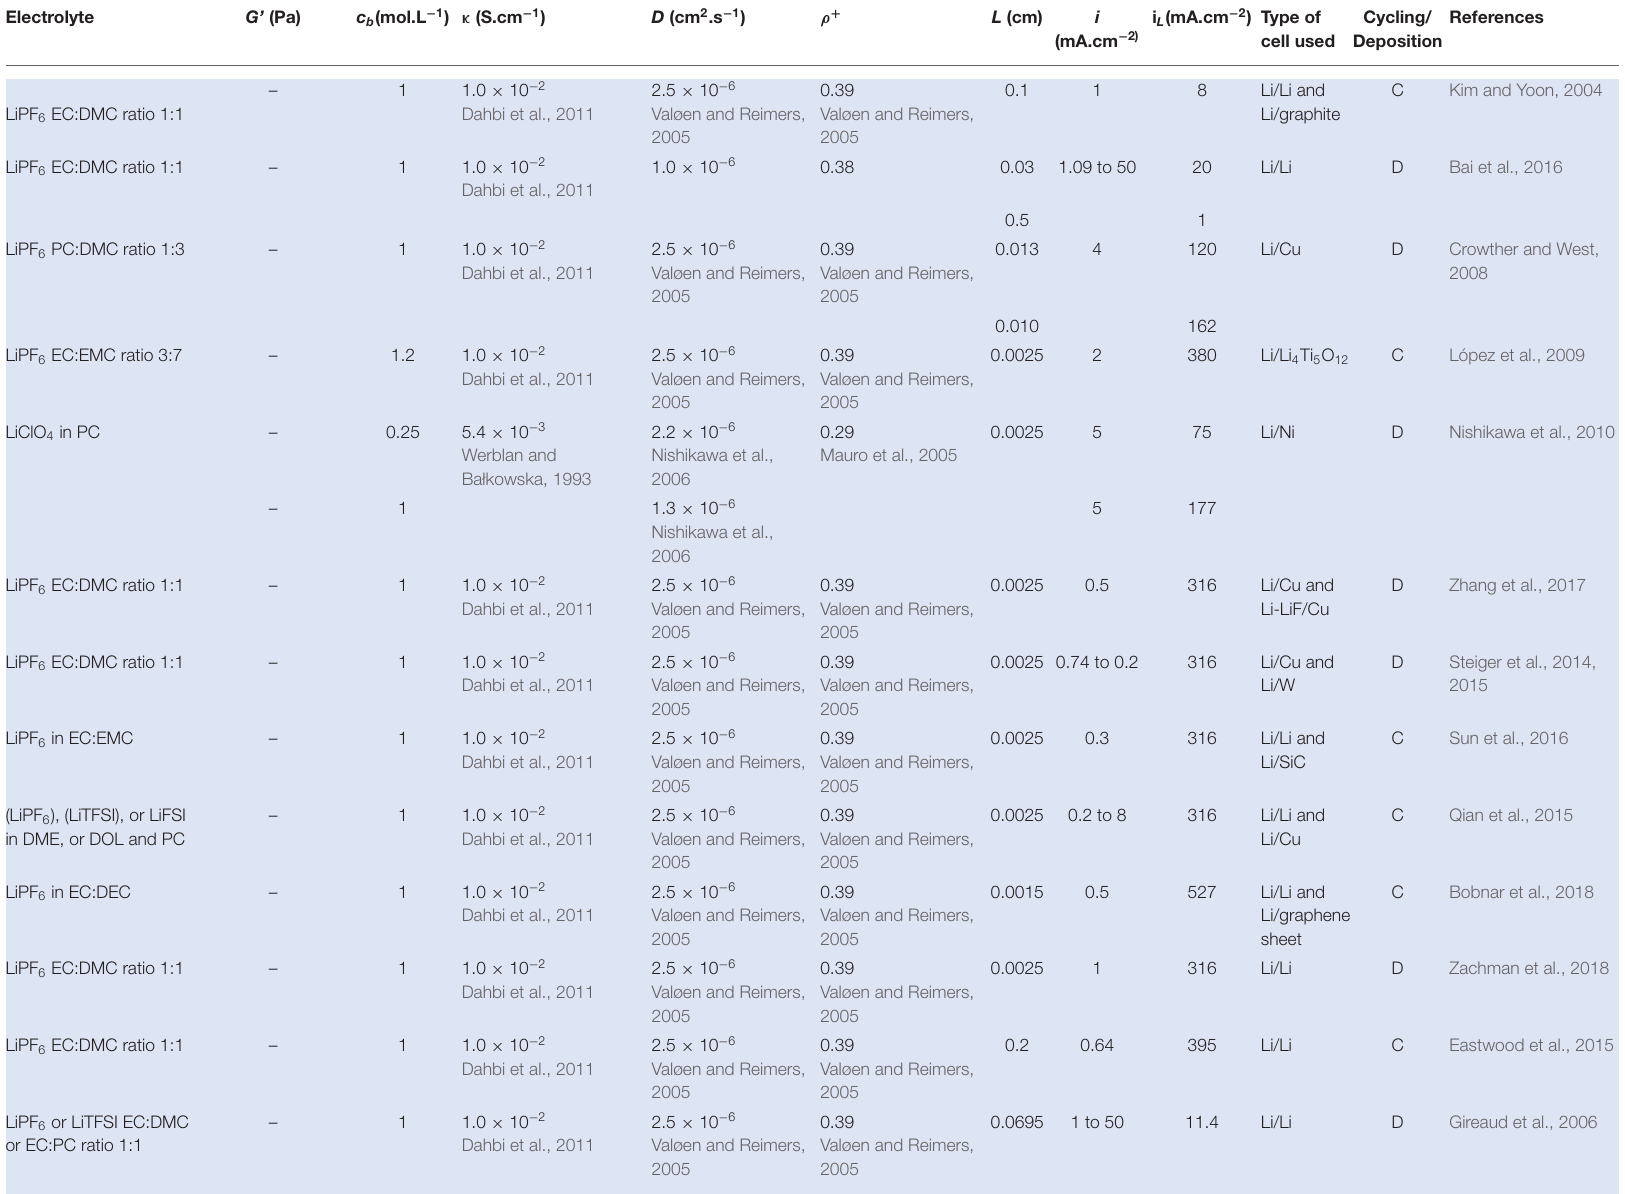
TABLE 4 | Properties of electrolytes and cells used to study lithium electrodeposition covered in this review. Electrolyte